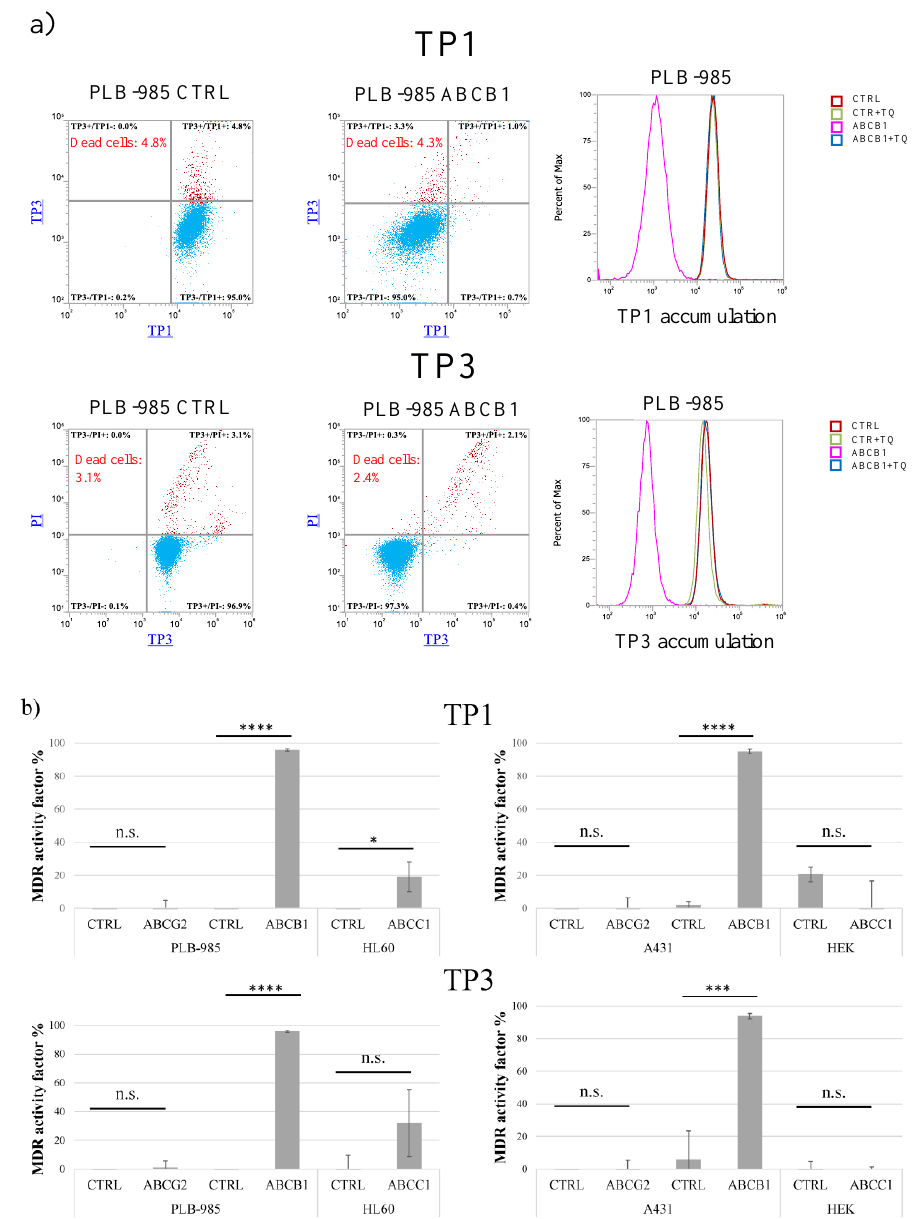
Figure 1. Uptake of TP dyes in human cells — effects of ABCG2, ABCB1, and ABCC1 expression in various cell types, measured by flow cytometry. ( a ) Uptake of 500 nM TP1 or 100 nM TP3 in PLB-985 control and ABCB1-expressing cells was measured after incubation for 24 h, at 37 °C. TP3 fluorescence was measured by Attune NxT flow cytometer with red laser (638 nm) in the RL1 channel (emission filter: 670/14 nm). Dead cells were identified based on PI staining (488 nm blue laser, emission filter: 695/40 nm). TP1 signal was measured by Attune NxT flow cytometer with blue laser (488 nm) in the BL1 channel (emission filter: 530/30 nm). Dead cells were identified based on TP3 staining (added immediately before measurement). Dead cells are labeled red, live cells are labeled blue. Experiments were repeated at least three times, the result of one representative experiment is shown. ( b ) MDR activity factors (see Methods) calculated by measuring inhibitor-sensitive TP1 or TP3 accumulation in various human cells, expressing ABCG2, ABCB,1 or ABCC1. Upper row: TP1 measurements, lower row: TP3 measurements. The specific inhibitors used were 2.5 µ M KO143, ABCB1 by 250 nM TQ, and ABCC1 by 10 µ M IM. SD +/- values are indicated. Statistical analysis was performed by Student’s t-test. n.s. not significant * p < 0.05 *** p < 0.001 **** p < 0.0001 ( n =